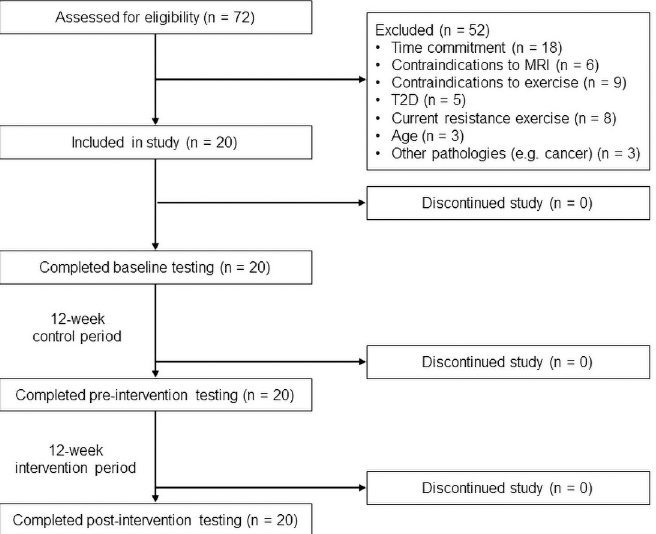
Fig 1. Flow diagram of participant recruitment and testing. 72 potential participants were assessed for eligibility. All 20 participants that were included in this study completed the required number of training sessions ( > 90%) and all assessments at baseline, pre-intervention, and post-intervention. There were no participant drop-outs or severe adverse events.